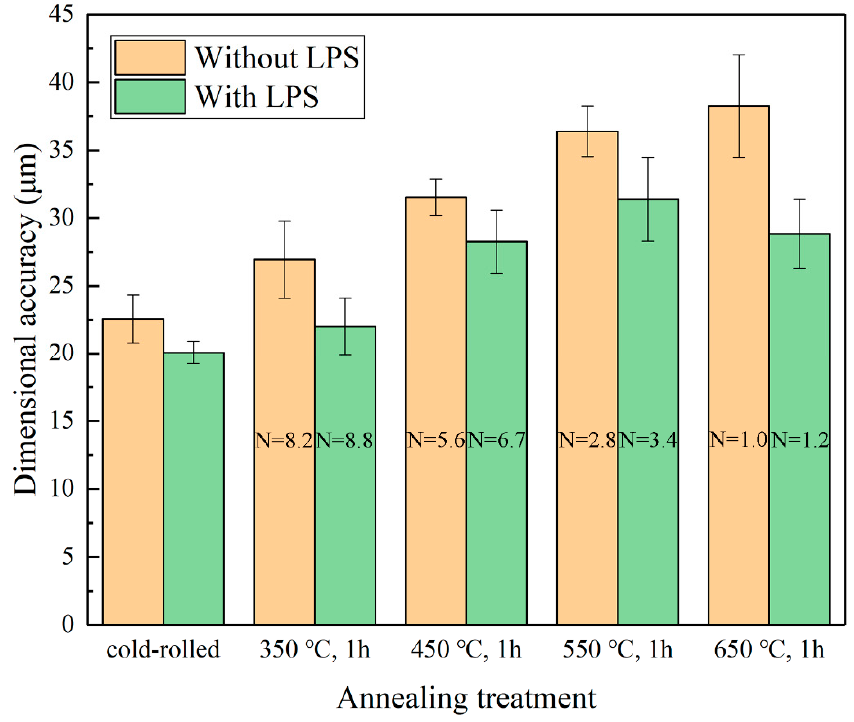
Figure 15. Influence of the initial grain size on the dimensional accuracy of punched holes with LPS and without LPS under a laser energy density of 38.2 J/cm 2 .